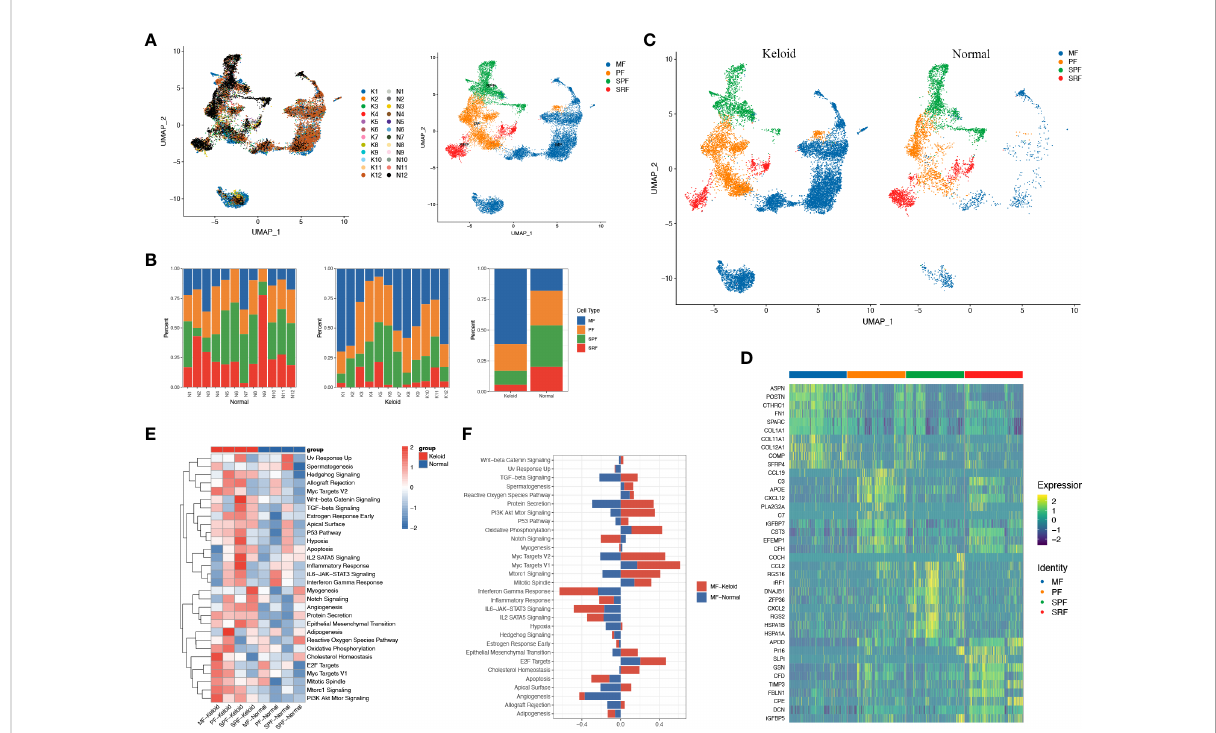
FIGURE 2 Fibroblasts of keloid and normal skin tissue subcluster into distinct cell populations. (A) Subclustering of keloid and normal tissue fi broblasts identi fi ed four distinct subtypes: mesenchymal (MF), pro-in fl ammatory (PF), secretory-papillary (SPF), and secretory-reticular (SRF). (B) Demonstration of the ratio of the four fi broblast subpopulations in keloids and adjacent normal tissue. (C) Color-coded UMAP plot is shown, and each fi broblast subcluster is de fi ned. (D) Heatmap plots showing representative differentially expressed genes between the four fi broblasts in the keloids. (E) Gene ontology (GO) biological process enrichment analysis of differentially expressed genes in the four fi broblasts between keloid and normal scars. (F) GO enrichment analysis of differentially expressed genes in mesenchymal fi